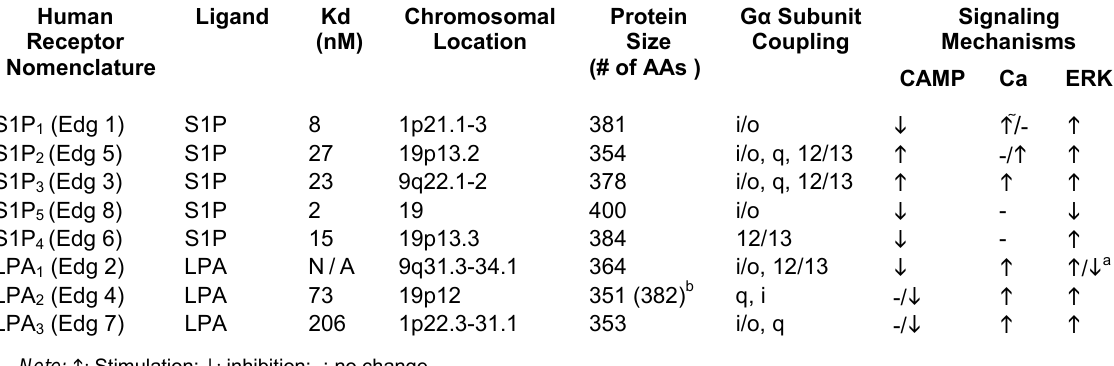
S1P and LPA Subfamily of G Protein-Coupled Receptors: Structure and Signaling Mechanisms